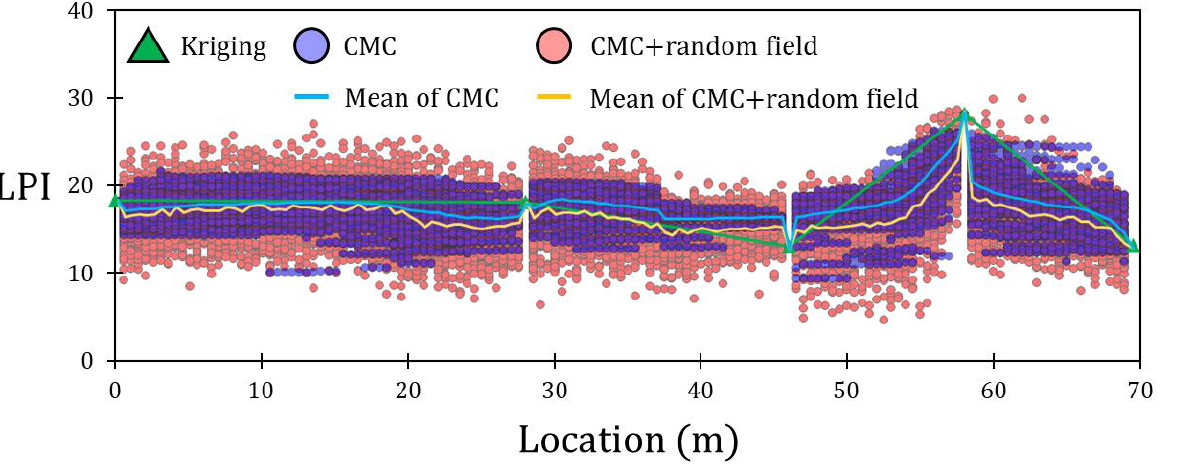
Figure 11. Comparison of the liquefaction-potential-evaluation results of three models through the JRA method. Most of the results of the Kriging method (see the green lines in Figures 10 and 11) were within the limits of the results derived through the CMC method. Furthermore, in Location = 46 and 57 in Figure 10 and Location = 0 and 57 in Figure 11, the Kriging- method results are close to the extreme values in the CMC-method results. Nonetheless, this finding was acquired through actual borehole analysis. Therefore, this would be a disadvantage of the Kriging method. This means that the liquefaction potential may be overestimated or underestimated if the Kriging method only is used. When evaluating the liquefaction potential using the HBF approach, the average results of every virtual bore- hole generated through the CMC method incorporating homogenous-soil parameters and random-field parameters were 0.74 – 2.2 and 0.68 – 1.17 times higher than those of the Kriging method, respectively. When evaluating the liquefaction potential using the JRA approach, the average results of every virtual borehole generated through the CMC method incorporating homogenous-soil parameters and random-field parameters were 0.81 – 1.17 and 0.81 – 1.09 times higher than those of the Kriging method, respectively. This study does not discuss whether the HBF approach or the JRA approach is more suitable for Taiwan because this would require more actual liquefaction data. In Figures 10 and 11, the results of the CMC method incorporating homogenous-soil parameters and random-field parameters are shown in light purple and pink, respec- tively, while the overlay region is presented in dark purple. Comparing both methods, the latter generated a larger liquefaction-potential-result interval than the former in most